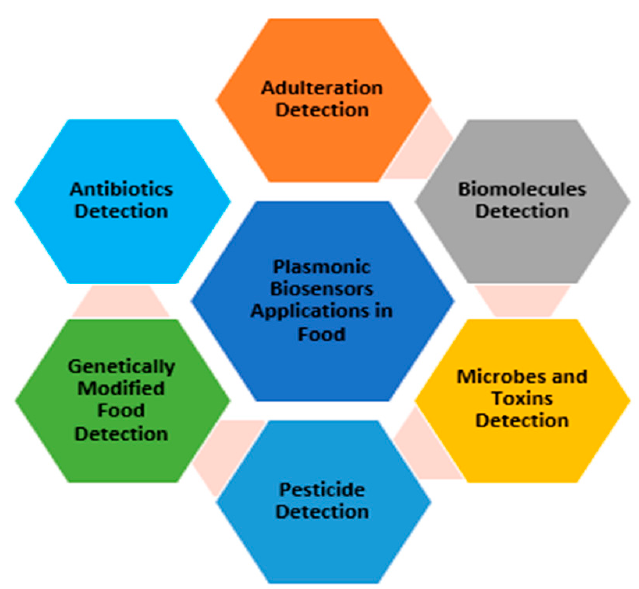
Figure 13. Schematic diagram of applications of plasmonic biosensors in monitoring food.